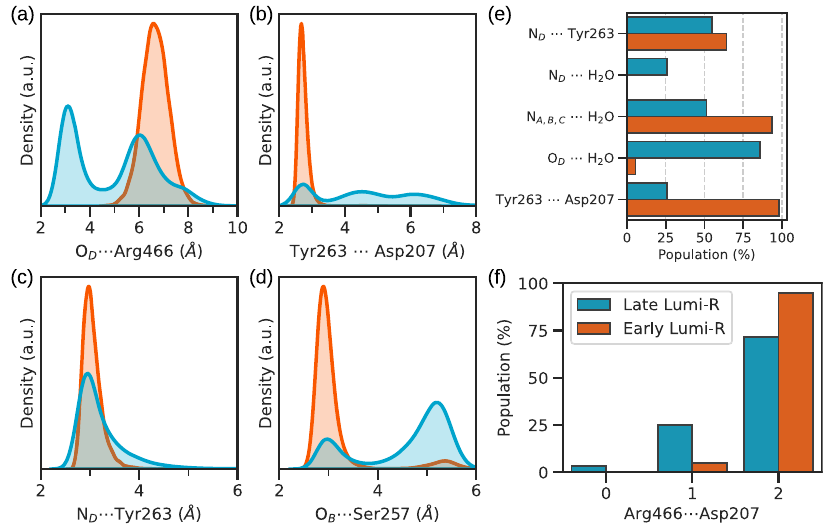
Fig. 6 | Late Lumi-R intermediate. a − d Distance distributions computed for the O D ⋯ Arg466, Tyr263 ⋯ Asp207, N D ⋯ Tyr263, and O B ⋯ Ser257 interactions, respectively. e Probabilities for the main hydrogen-bonding interactions around the D-ring f Probabilitiesof having 0,1,or 2contacts between Asp207and Arg466. We de fi ne a contact if the Asp207 oxygens, and Arg466 nitrogens are less than 3Å apart. We compared the Early Lumi-R (in blue) against the Late Lumi-R